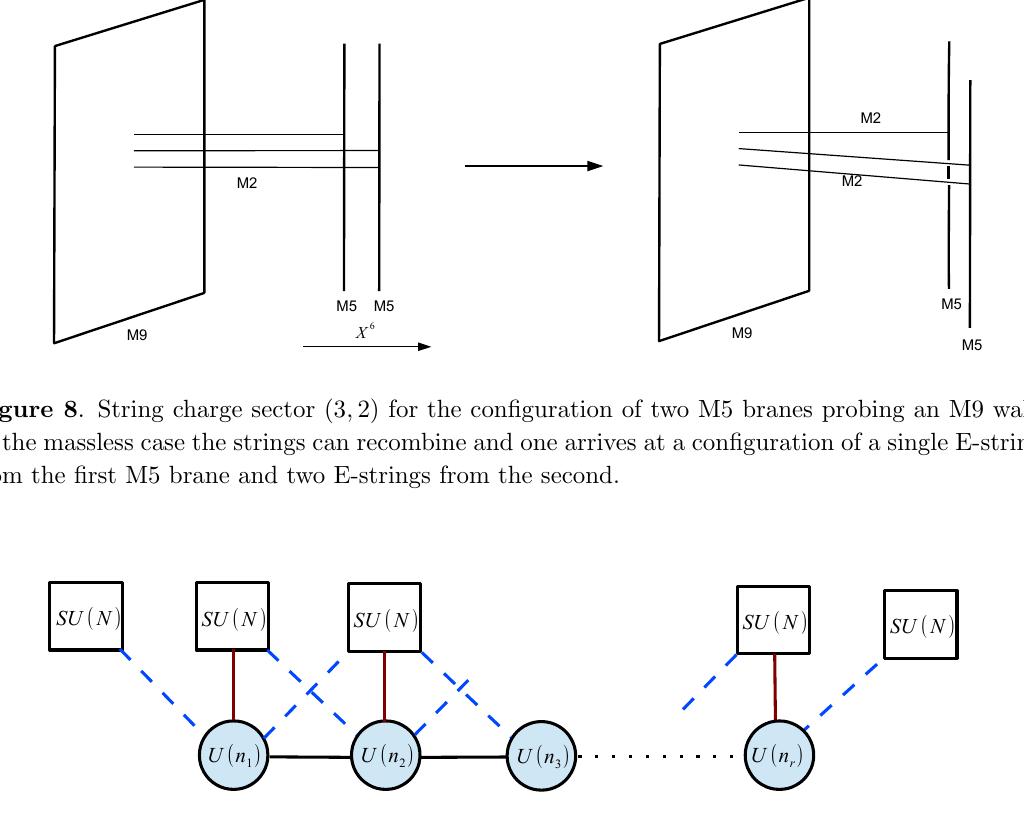
Figure 9 . Quiver gauge theory for the non-critical strings of N D5 branes probing an A r singularity. Note that the global symmetry are obtained from the a(cid:14)ne b A r quiver by ‘opening up’ the quiver at the a(cid:14)ne